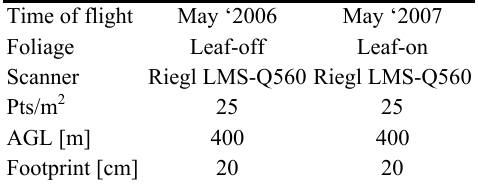
Figure 5. Single tree detection of sample area with 3D